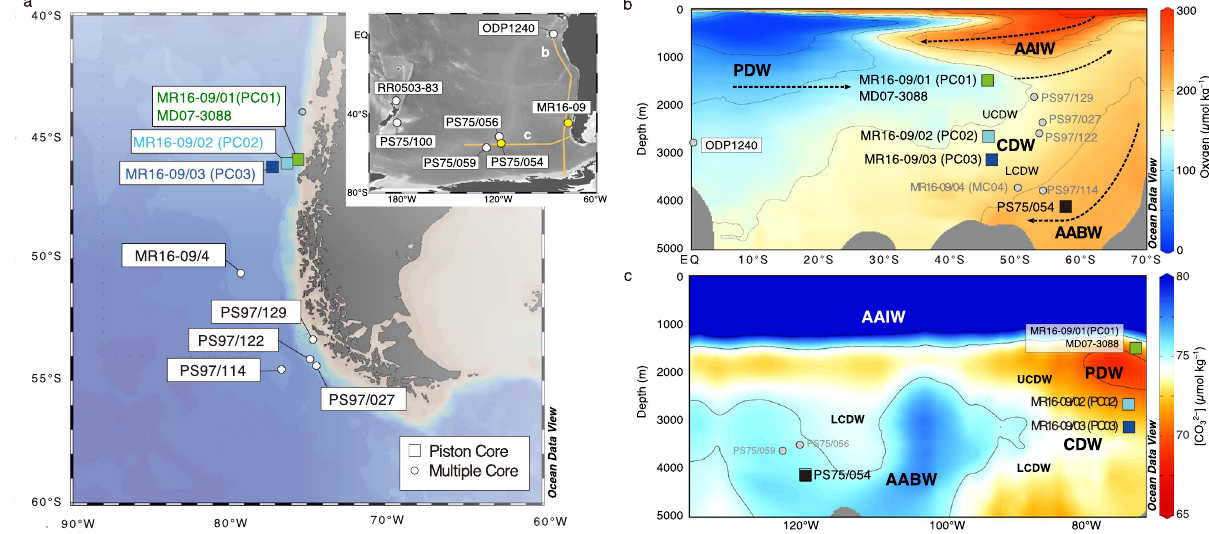
Fig. 1 | Cores location and study area. a Location of piston cores of MR16-09 (PC01: 46° 04 ′ S, 75° 41 ′ W; 1537m water depth, PC02: 46° 04 ′ S, 76° 32 ′ W; 2787m water depth, PC03: 46° 24 ′ S, 77° 19 ′ W; 3074m water depth), and location of mul- tiplecoresanalyzedinthisstudy.TheenlargedmapshowslocationsofPS75/054 − 1 (56°S, 115°W, 4085m) and core sites referred to in this study. b Cross-sections of